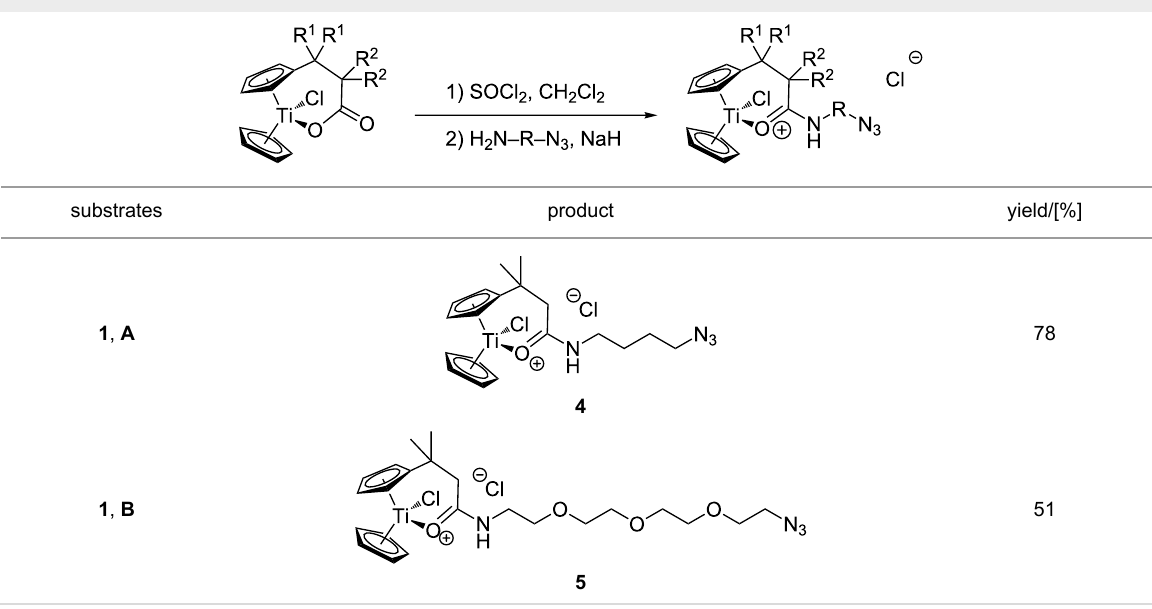
Table 1: Synthesis of cationic titanocenes containing azides (yield over two steps, see Supporting Information File 1 for details).